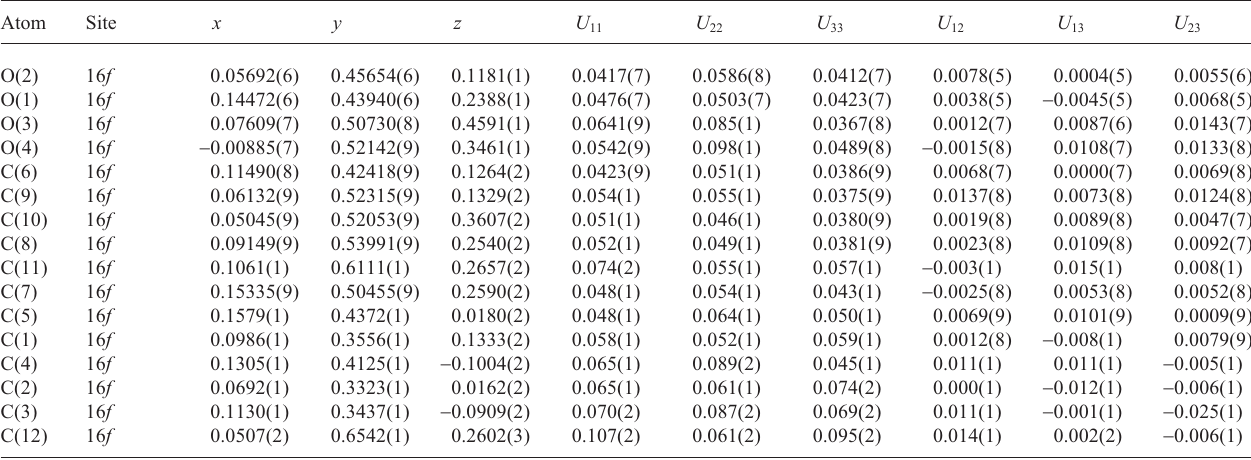
Table 3. Atomic coordinates and displacement parameters (in Å 2 )